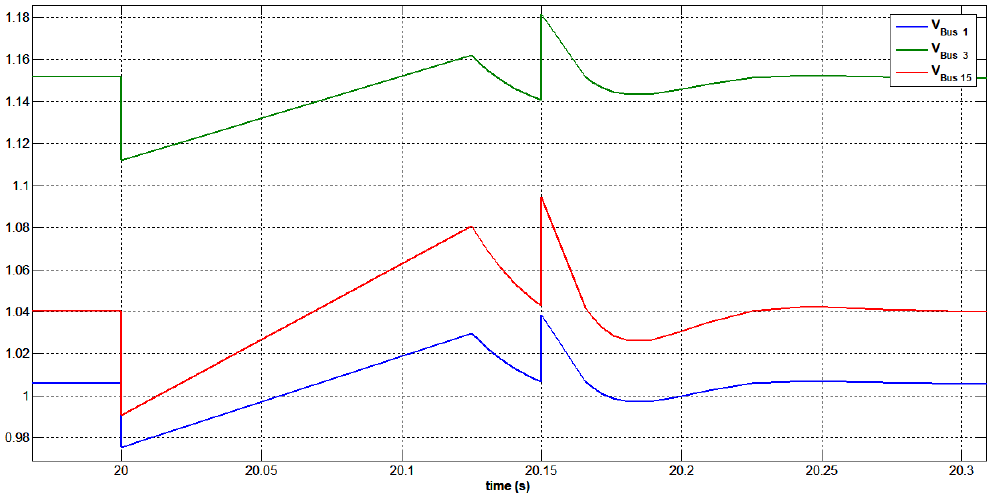
Figure 44. Voltage variation at buses 1, 3, and 15 under a three ‐ phase short circuit at bus 15 with STATCOM.